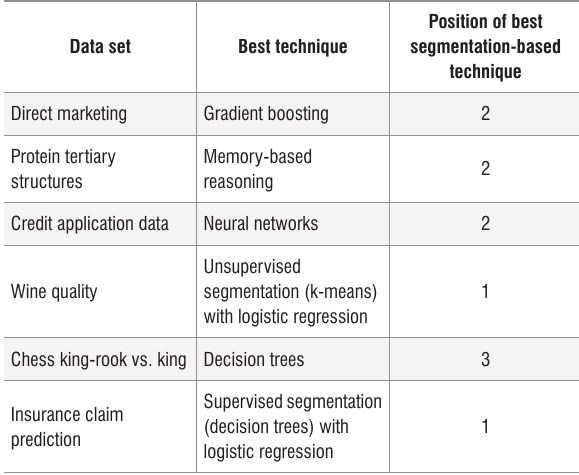
Position of best segmentation-based technique